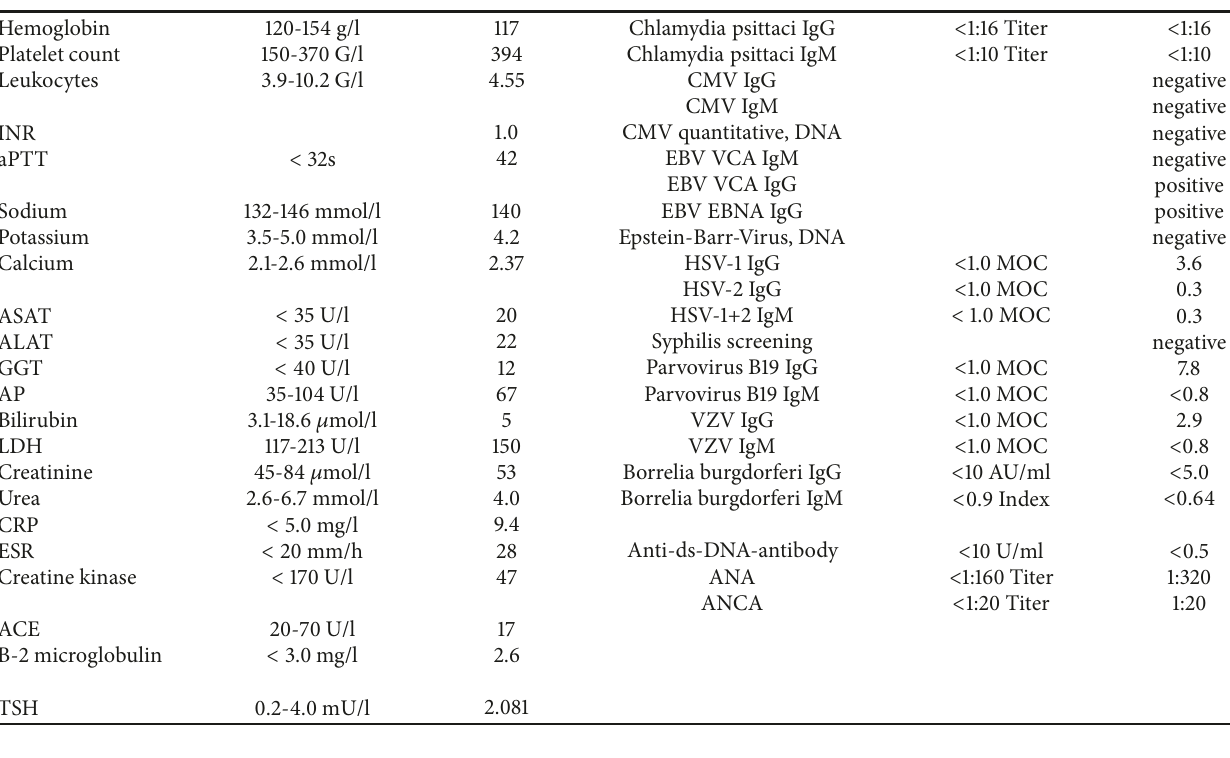
Table 1: Laboratory values .